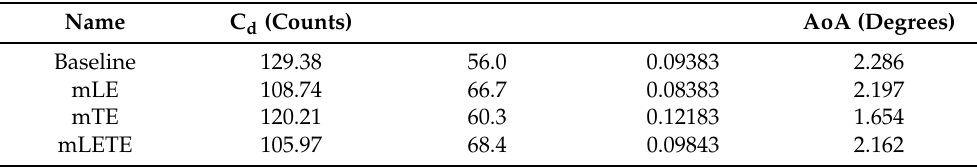
Table 1. Forces and corresponding angles of attack for baseline and optimized morphing airfoils at a constant lift coefficient of